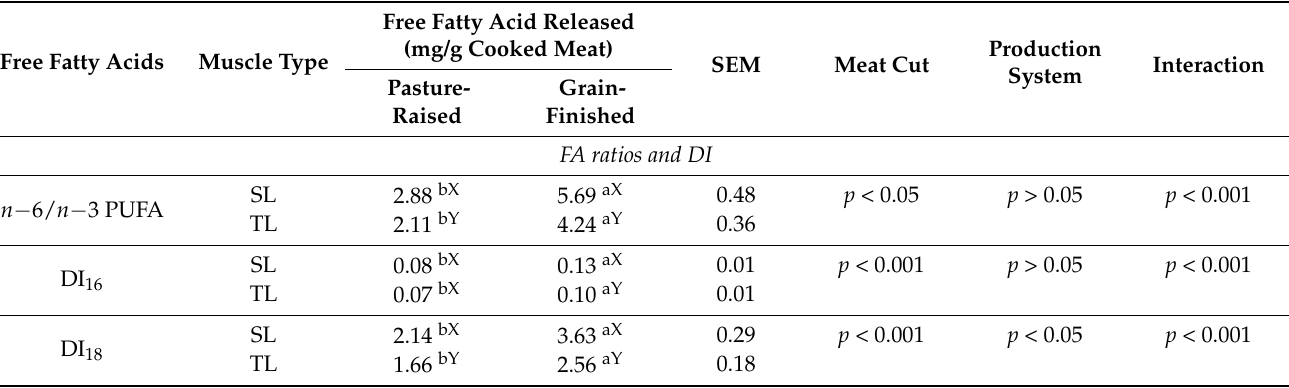
Table 6. Fatty acid ratios and desaturase indices (DI) for cooked striploin (SL) and tenderloin (TL) digests from pasture-raised and grain-finished animals after 180 min of digestion under simulated gastro-small intestinal